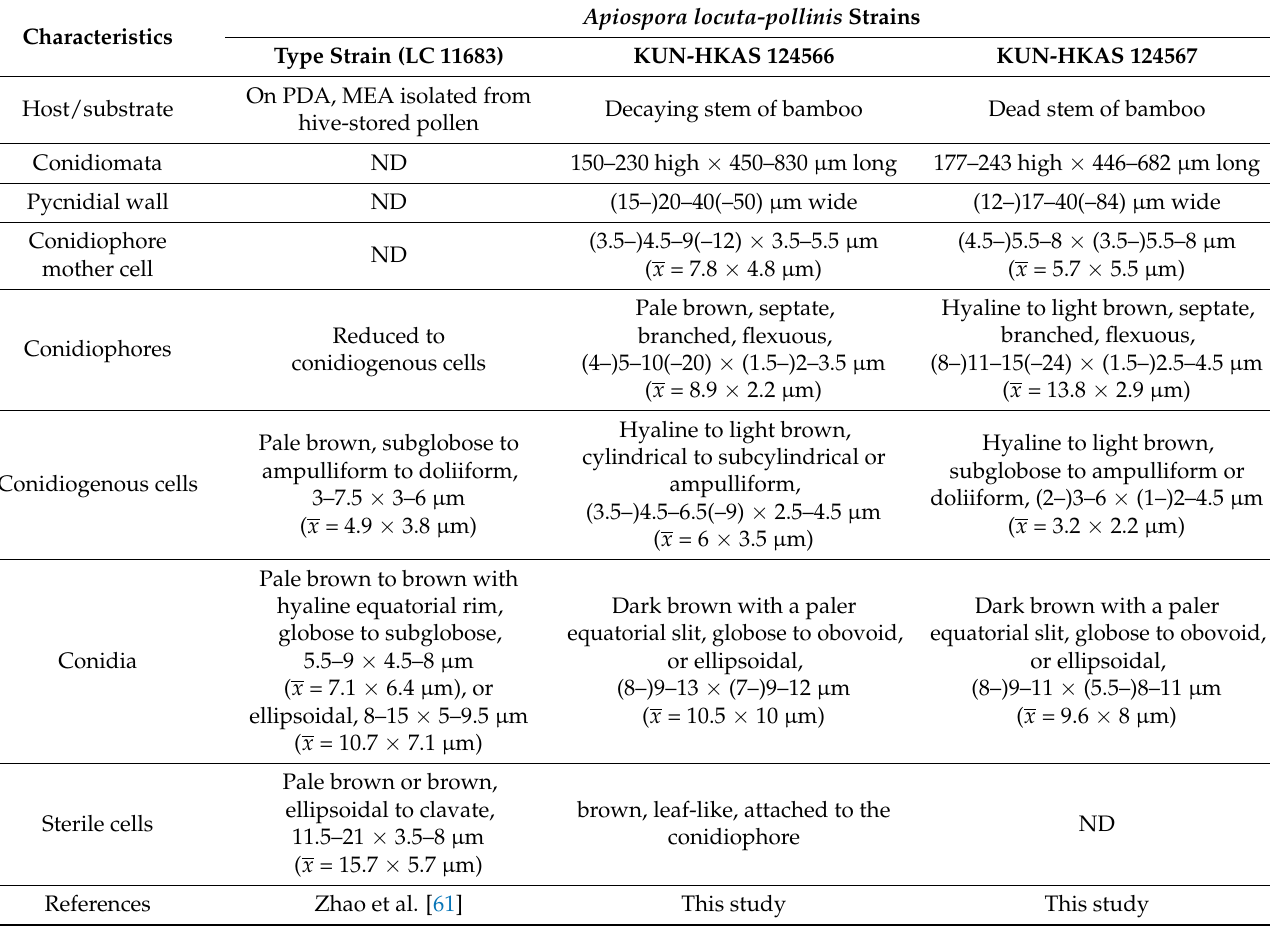
Table 2. Morphological comparison among Apiospora locuta-pollinis